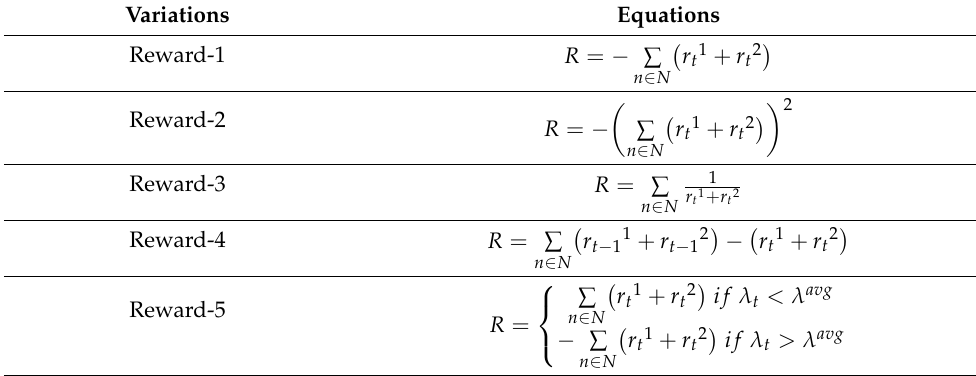
Table 1. Different reward representations.